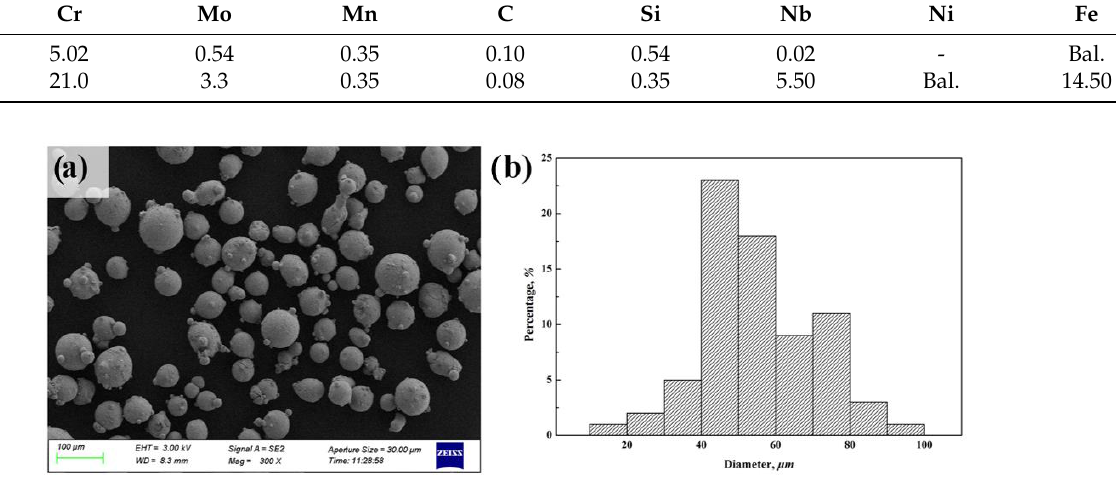
Figure 1. IN718 powder characterization: ( a ) SEM image of nearly spherical powder and ( b ) particle- size distribution.